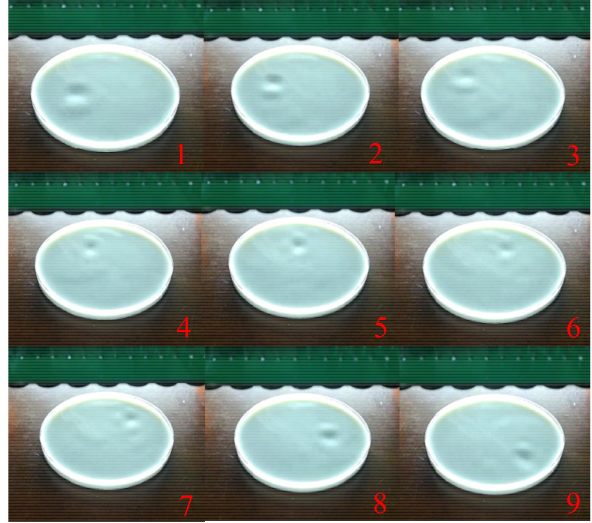
Figure 14. Dynamic rectangular partial continuous trajectory.